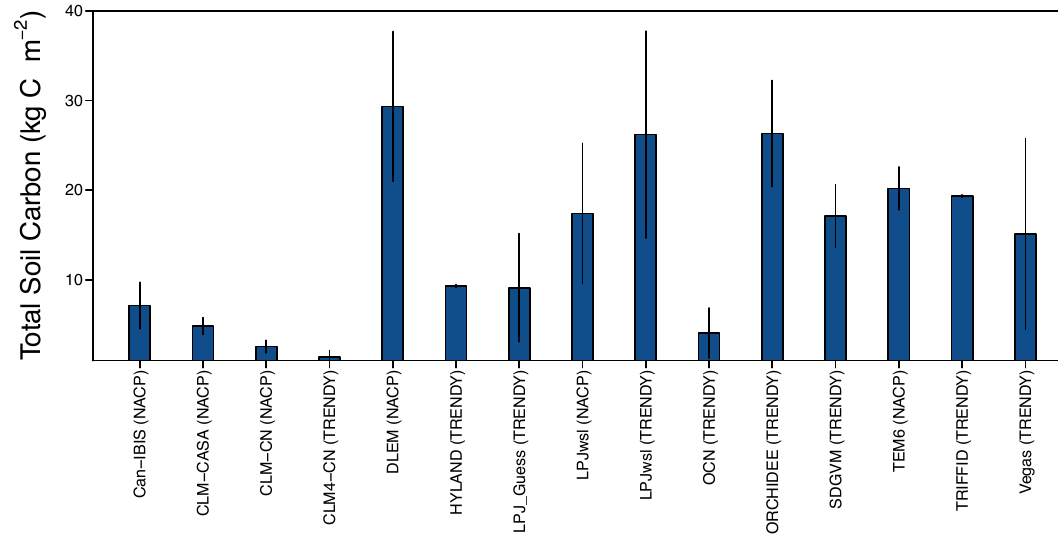
Figure 6. Mean annual Alaskan Arctic (North Slope) total soil carbon with spatial standard deviations. 956